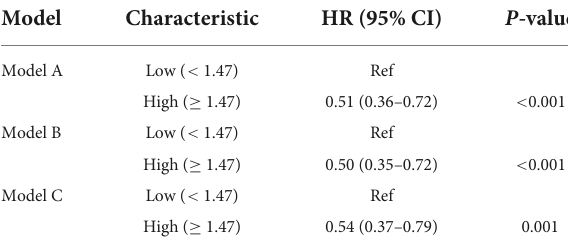
( Figure 2 ). Based on the post-TG cut-off, 91 ESCC patients were categorized into the high post-TG group ( > 1.47 mmol/L) and 166 in the low post-TG group ( < 1.47 mmol/L).